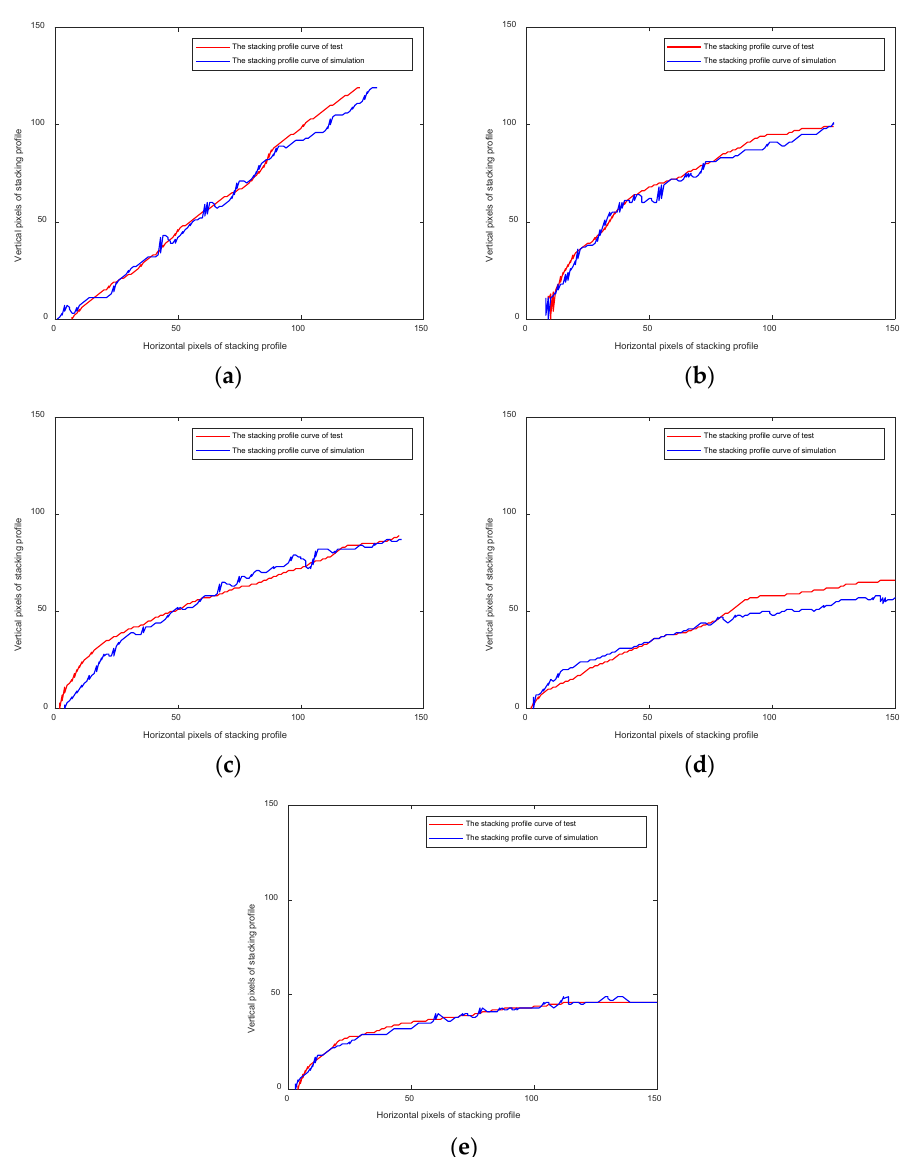
Figure 15. Accumulations of tests and simulations with five types of soil. The edge curves of soil accumulation and DEM particle accumulation shapes were extracted. Two edge curves are compared by pixel superposition. ( a ) Pixel superposition of sand. ( b ) Pixel superposition of clay. ( c ) Pixel superposition of mixed soil 1#. ( d ) Pixel superposition of mixed soil 2#. ( e ) Pixel superposition of mixed soil 3#.